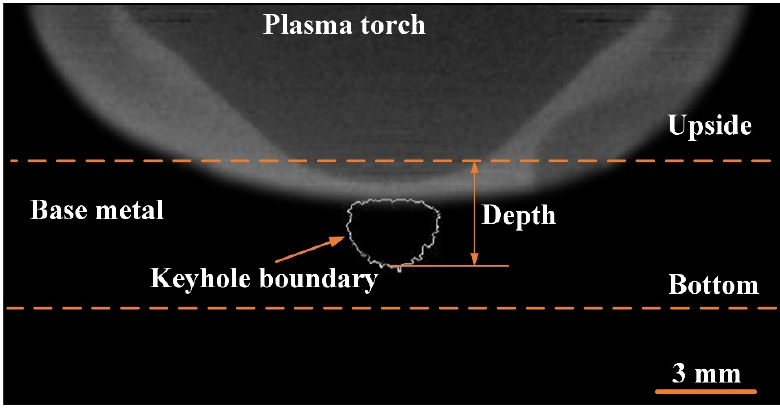
Figure 9. The keyhole boundary indicated by image edge extraction.